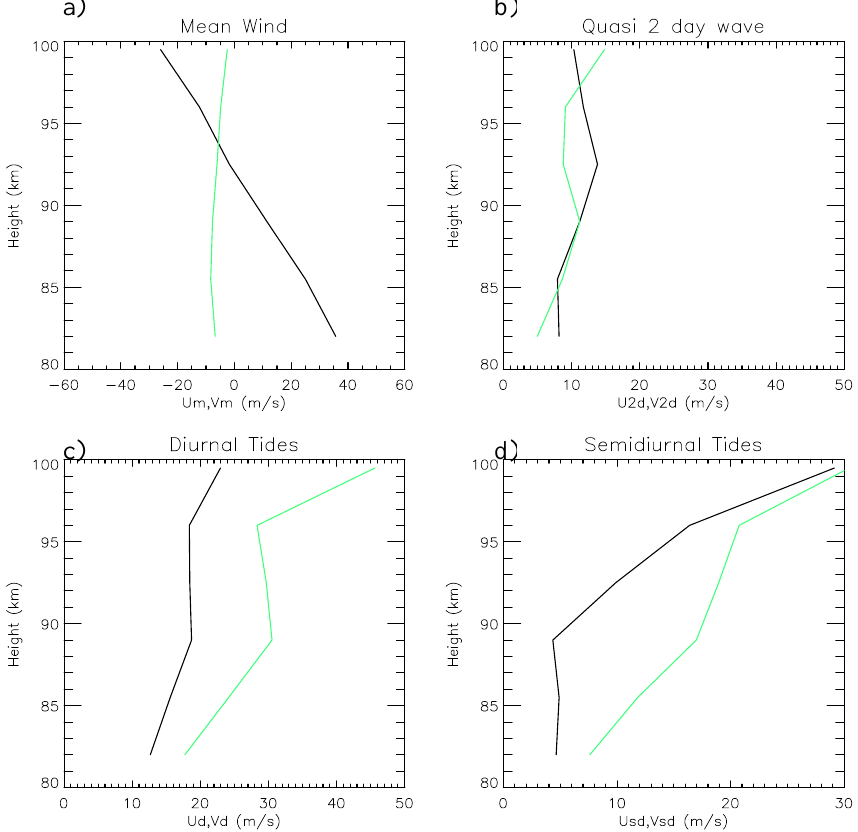
Fig. 19. Monthly measurement of (a) zonal (black) and meridional (green) mean winds, (b) quasi-two day planetary wave amplitudes, (c) diurnal tide amplitudes, and (d) semidiurnal tide amplitudes, for CP May 2005 using MCD